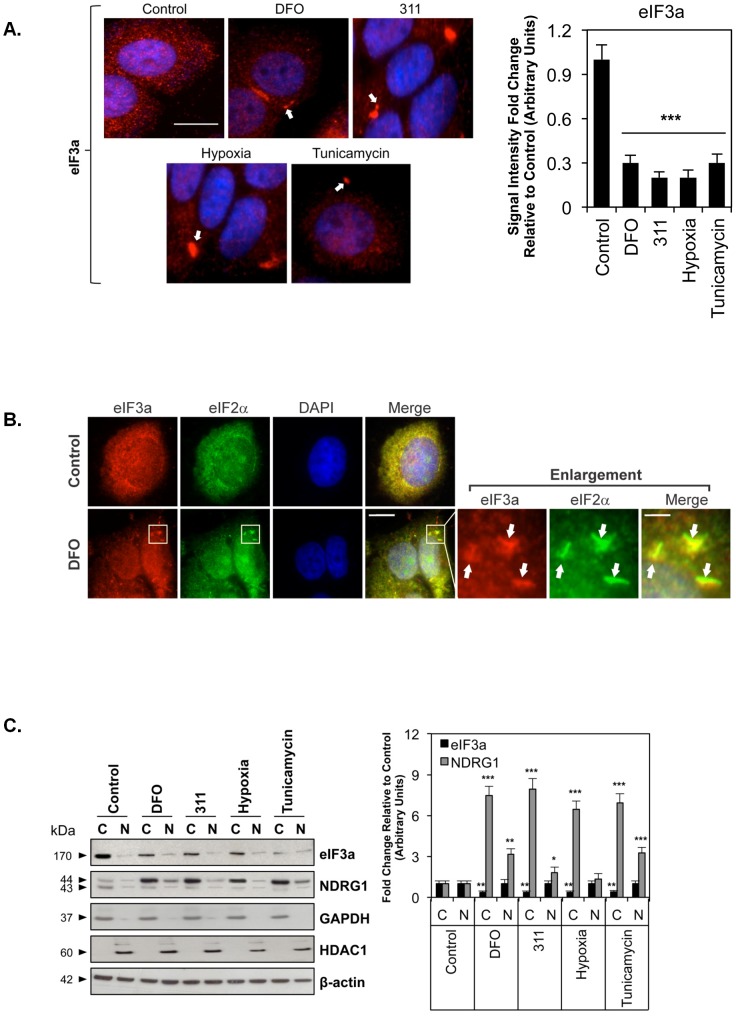
The distribution of eIF3a and NDRG1 after incubation of MCF7 cells with DFO (250 µM), 311 (25 µM), tunicamycin (5 µg/mL) or hypoxia (1% O2).(A) Cells were incubated using these conditions for 24 h/37°C and then stained with primary antibody against eIF3a (Alexa Fluor 555; “red”) and DAPI. Scale bar: 10 µm. (B) Co-localization of the stress granule markers eIF3a and eIF2α (Alexa Fluor 488; “green”) in structures consistent with stress granules after incubation with DFO under the conditions used in (A). The enlarged views of the boxed region in the merge panel are displayed to the right of this panel and show separate views for the red and green channels of the same field in which there is a cluster of eIF3a- and eIF2α-positive stress granules. The white arrows point to these structures. The scale bar in the left-most merge image represents 10 µm, while the scale bar in the enlarged merge image represents 2 µm. (C) Fractionation of MCF7 cells followed by western analysis demonstrated the presence of eIF3a and NDRG1 in both the cytoplasm and nucleus. GAPDH and HDAC1 were used as positive and loading controls for isolation of cytoplasmic (C) and nuclear (N) fractions, respectively. β-actin was used as general protein loading control. The blots are representative of 3 experiments and the densitometric analysis is expressed as mean ± SD. *p<0.05, **p<0.01, ***p<0.001 relative to the control of the same fraction.